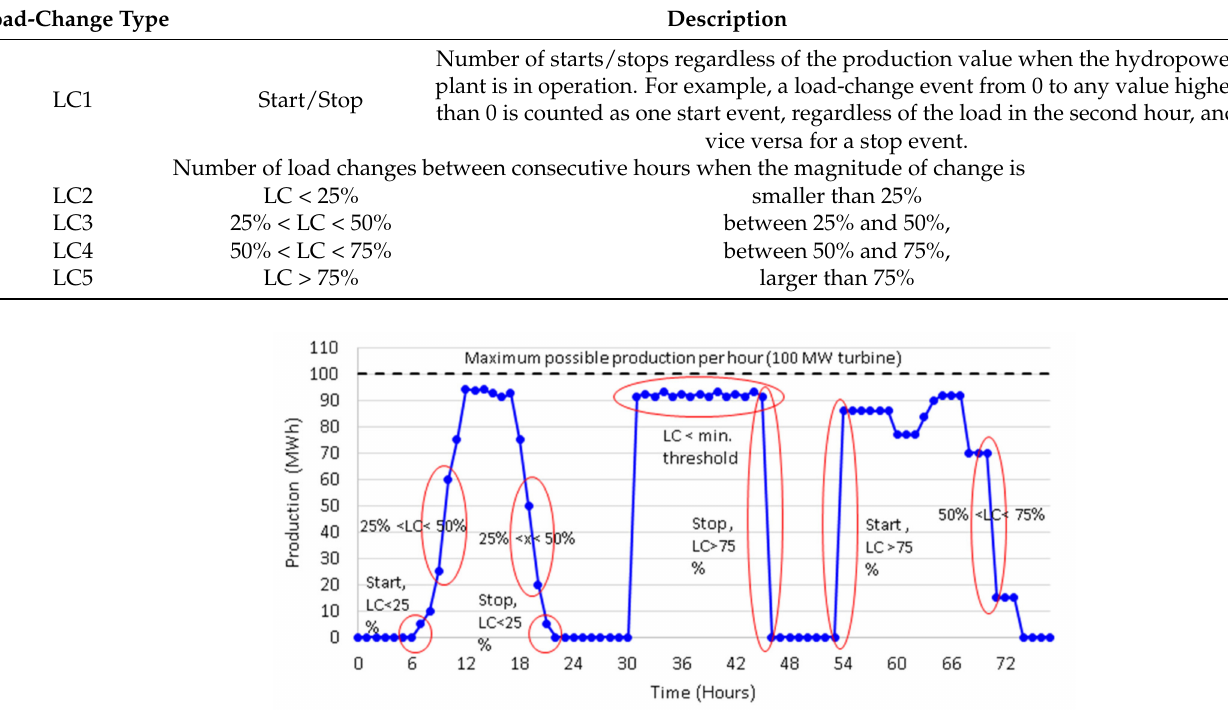
Figure 2. Illustration of the analysis